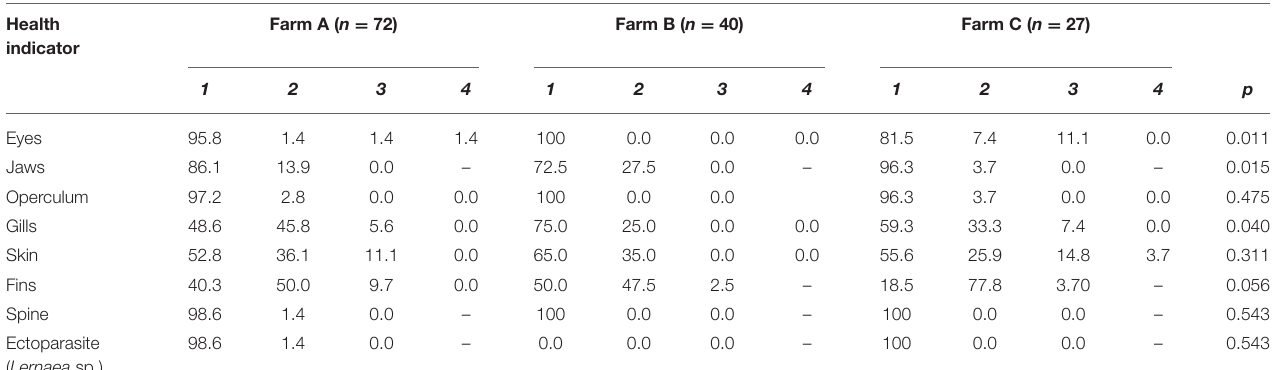
TABLE 6 | Health scores (%) and p -values in three different tilapia grow-out farms, data collected from January to March 2020 in South and Southeast Brazil; comparison amongst farms with Kruskal-Wallis test for all indicators. Health